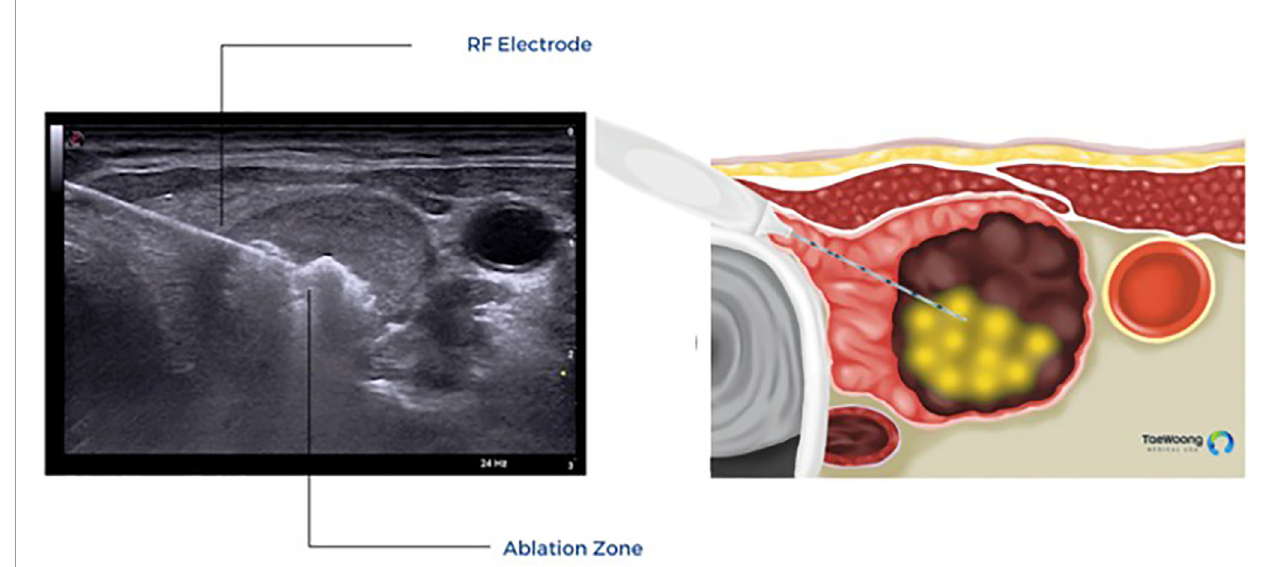
FIGURE 4 | Trans-isthmic approach and moving shot technique used in thermal ablation. (Permission to reprint from Taewoong Medical